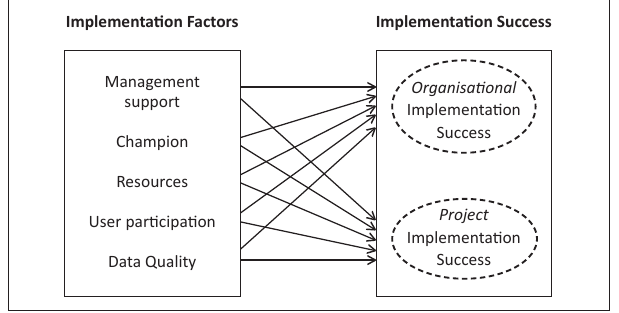
FIGURE 2: Proposed business intelligence project success